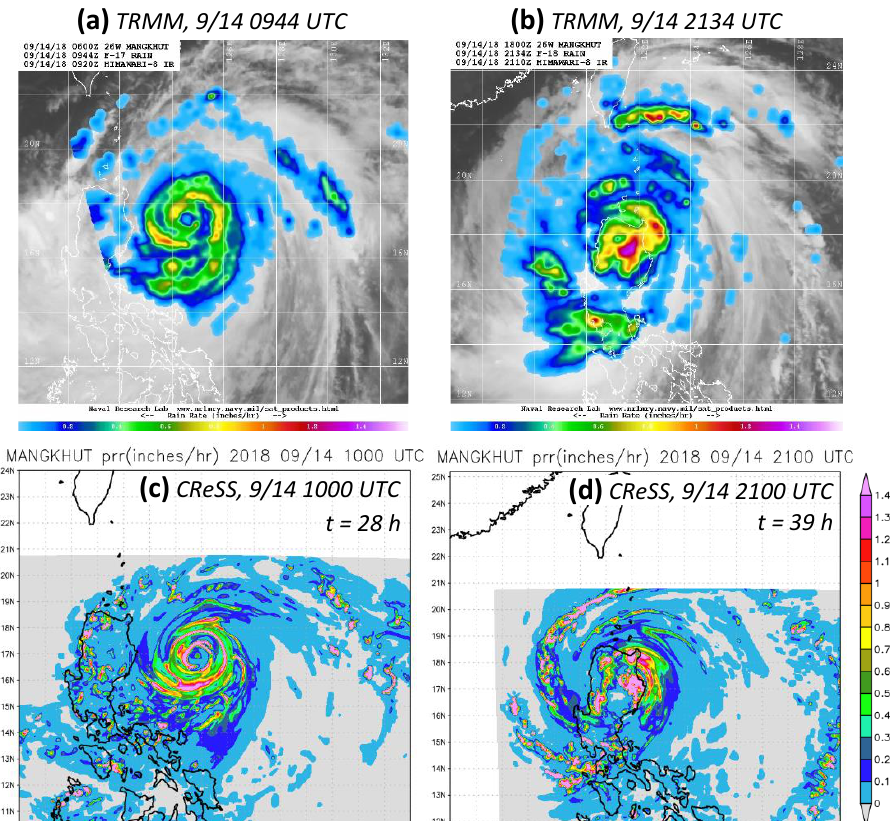
Figure 3. TRMM rainrate retrieval (inch h − 1 , color), overlaid on infrared cloud imagery by the Himawari-8 satellite at closest time, of TY Mangkhut (2018) at ( a ) 0944 and ( b ) 2134 UTC 14 September (source: NRL), and model rainrate (inch h −1 , color) valid at ( c ) 1000 and ( d ) 2100 UTC 14 September from the forecast initialized at 0600 UTC 13 September 2018 (forecast hour labeled). The region plotted and color scale used are similar for each pair.